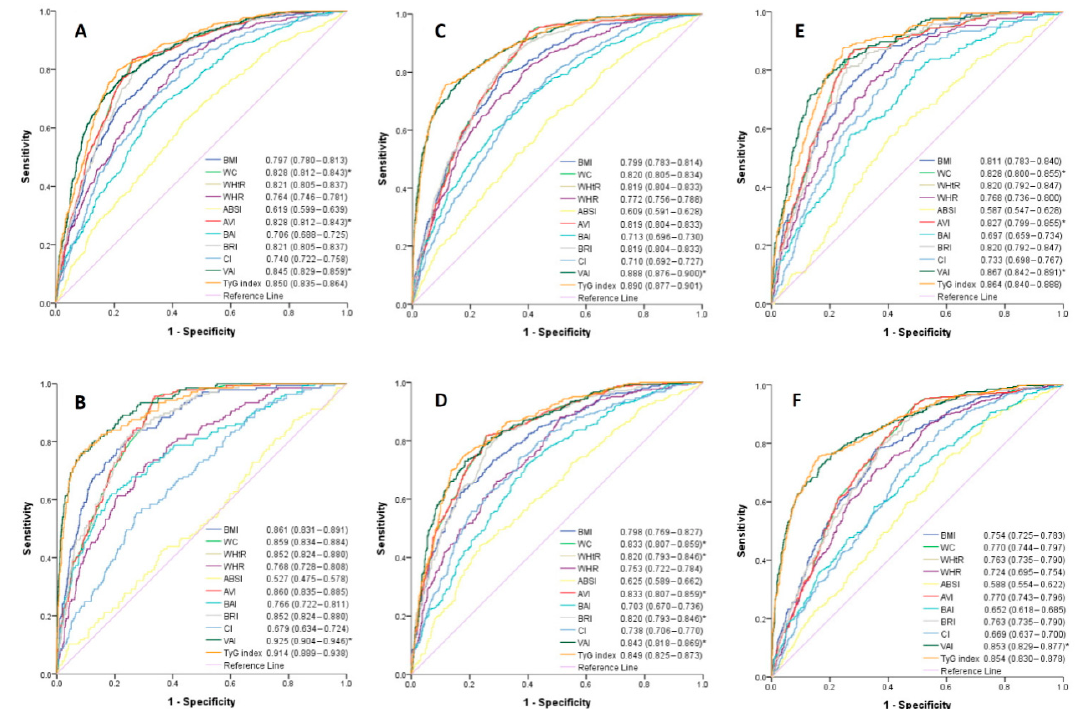
Figure 2. Comparison of the predictive value of 11 obesity-related parameters for diagnosis of metabolic syndrome among ( A ) all males, ( B ) all females, ( C ) males aged 30 − 50 years, ( D ) females aged 30 − 50 years, ( E ) males aged 51 − 70 years, and ( F ) females aged 51 − 70 years. * p -value > 0.05 when compared with area under curve of TyG index using the DeLong method.